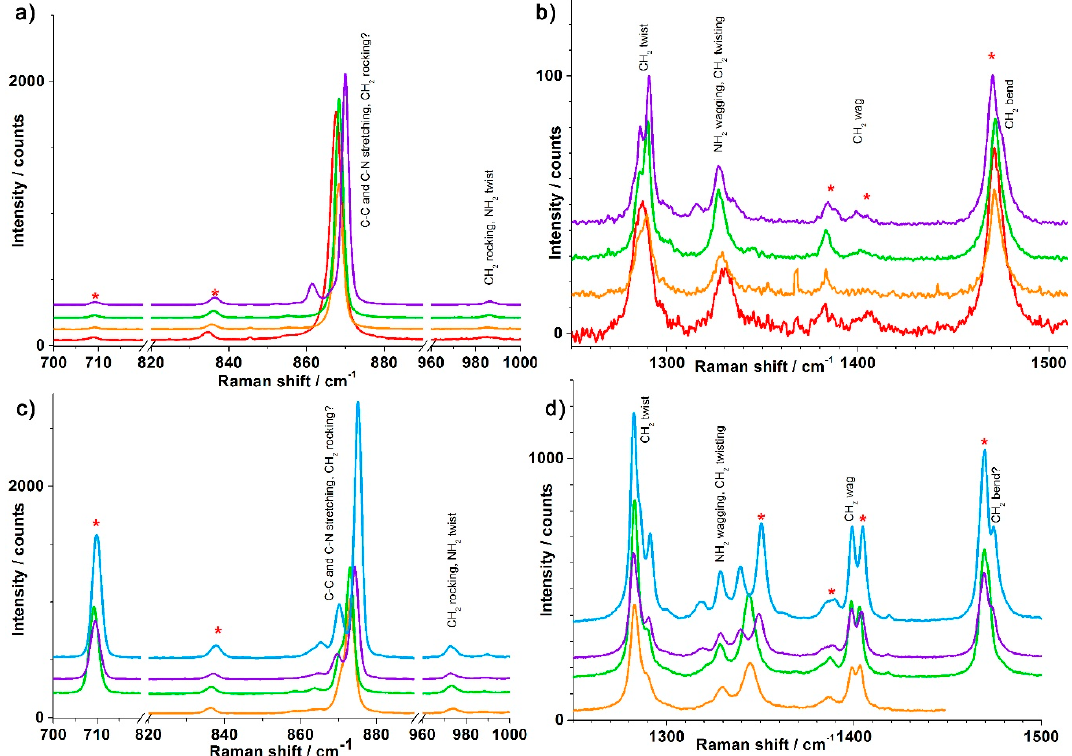
Figure6. Ramanspectrafor(top)[Mn(en) 3 ](NO 3 ) 2 at298(red), 200(orange), 155(green), and140K(light blue) in the ( a ) 700–720, 820–1000 cm − 1 and ( b ) 1250–1510 cm − 1 ranges and (bottom) [Zn(en) 3 ](NO 3 ) 2 at 200 (orange), 155 (green), 135 (violet), and 100 K (blue) in the ( c ) 700–720, 820–1000 cm − 1 and ( d ) 1250–1500 cm − 1 ranges. The bands indicated with a red star are resonances supposed to be mainly due to NO 3 in comparison to literature